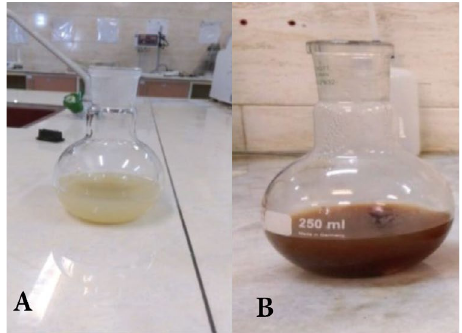
Fig. 1.The crude extract of Avena sativa L. mixed without AgNo (A) and with AgNo (B) after 24 h. It is observed that the color of 3 the solution turned from yellow to dark brown after 24 h of the reaction, indicating the formation of silver nanoparticles.